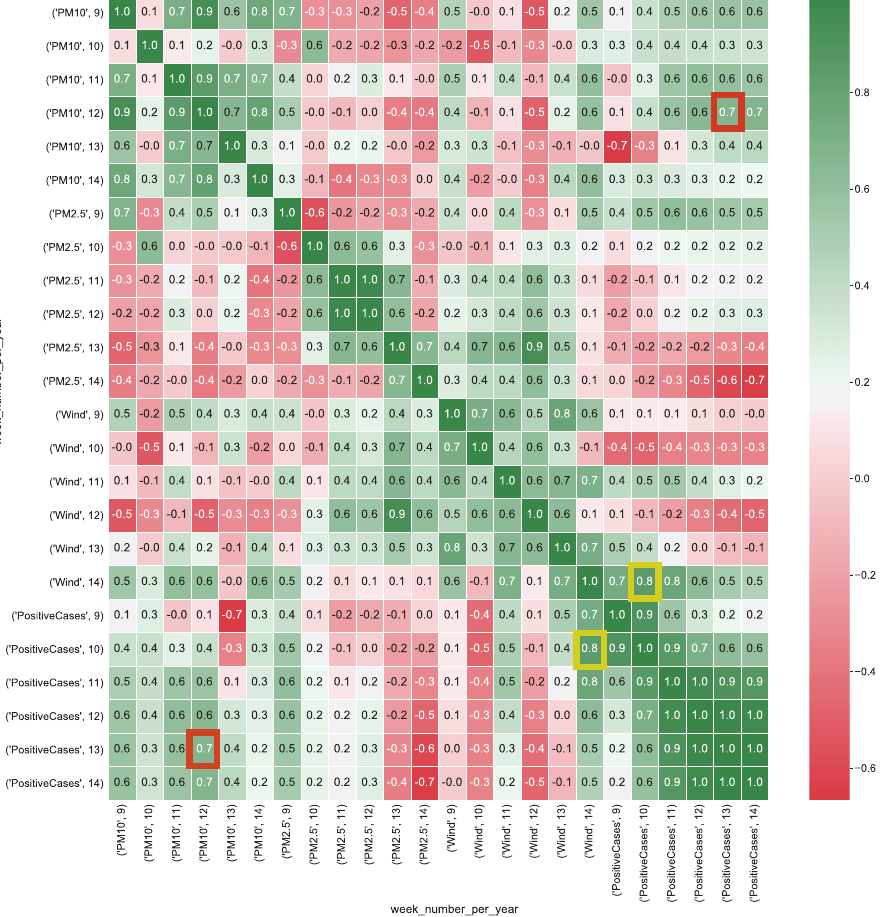
Figure 4. Heatmap represents the correlation between aggregated COVID-19 data with air pollution and wind data (km/h) detected in the Lombardia region. The heatmap’s labels refer to the attribute’s measured value in a specific week of the year. For instance, ’PM10’, 9 refers to the level of PM10 ( µ g/m 3 ) in the air measured in the 9-th week of the year. In Figure, the yellow squares highlight the strong correlation between positive cases and the presence of wind, whereas red squares show the strong correlation between air particulate and the number of positive